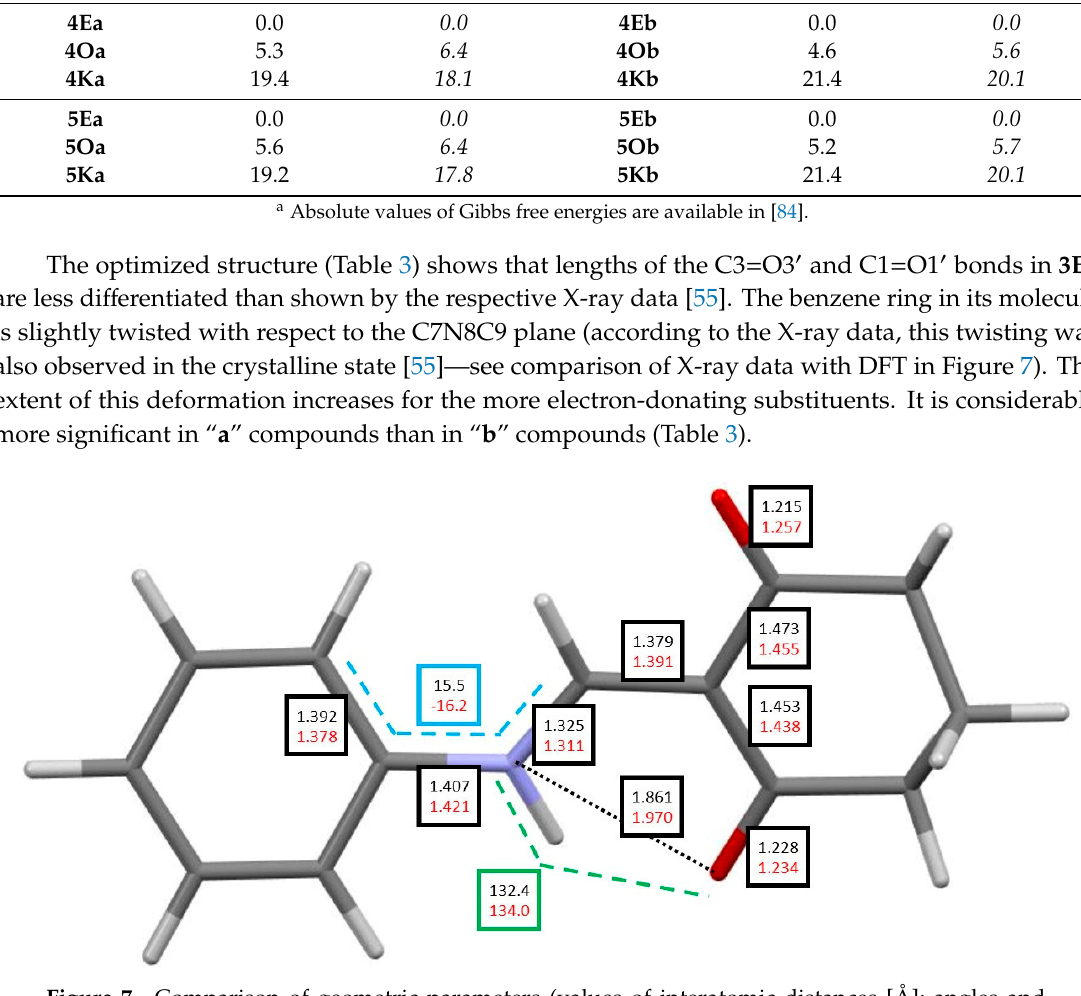
Figure 7. Comparison of geometric parameters (values of interatomic distances [Å]; angles and torsional angles [°]; corresponding black, green, and blue frames, respectively), for DFT (black font) and X-Ray [55] (red font) for 3Ea.